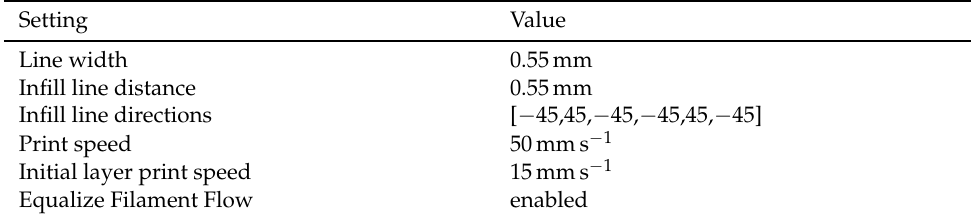
Table 11. Slicer settings − 45°/45°